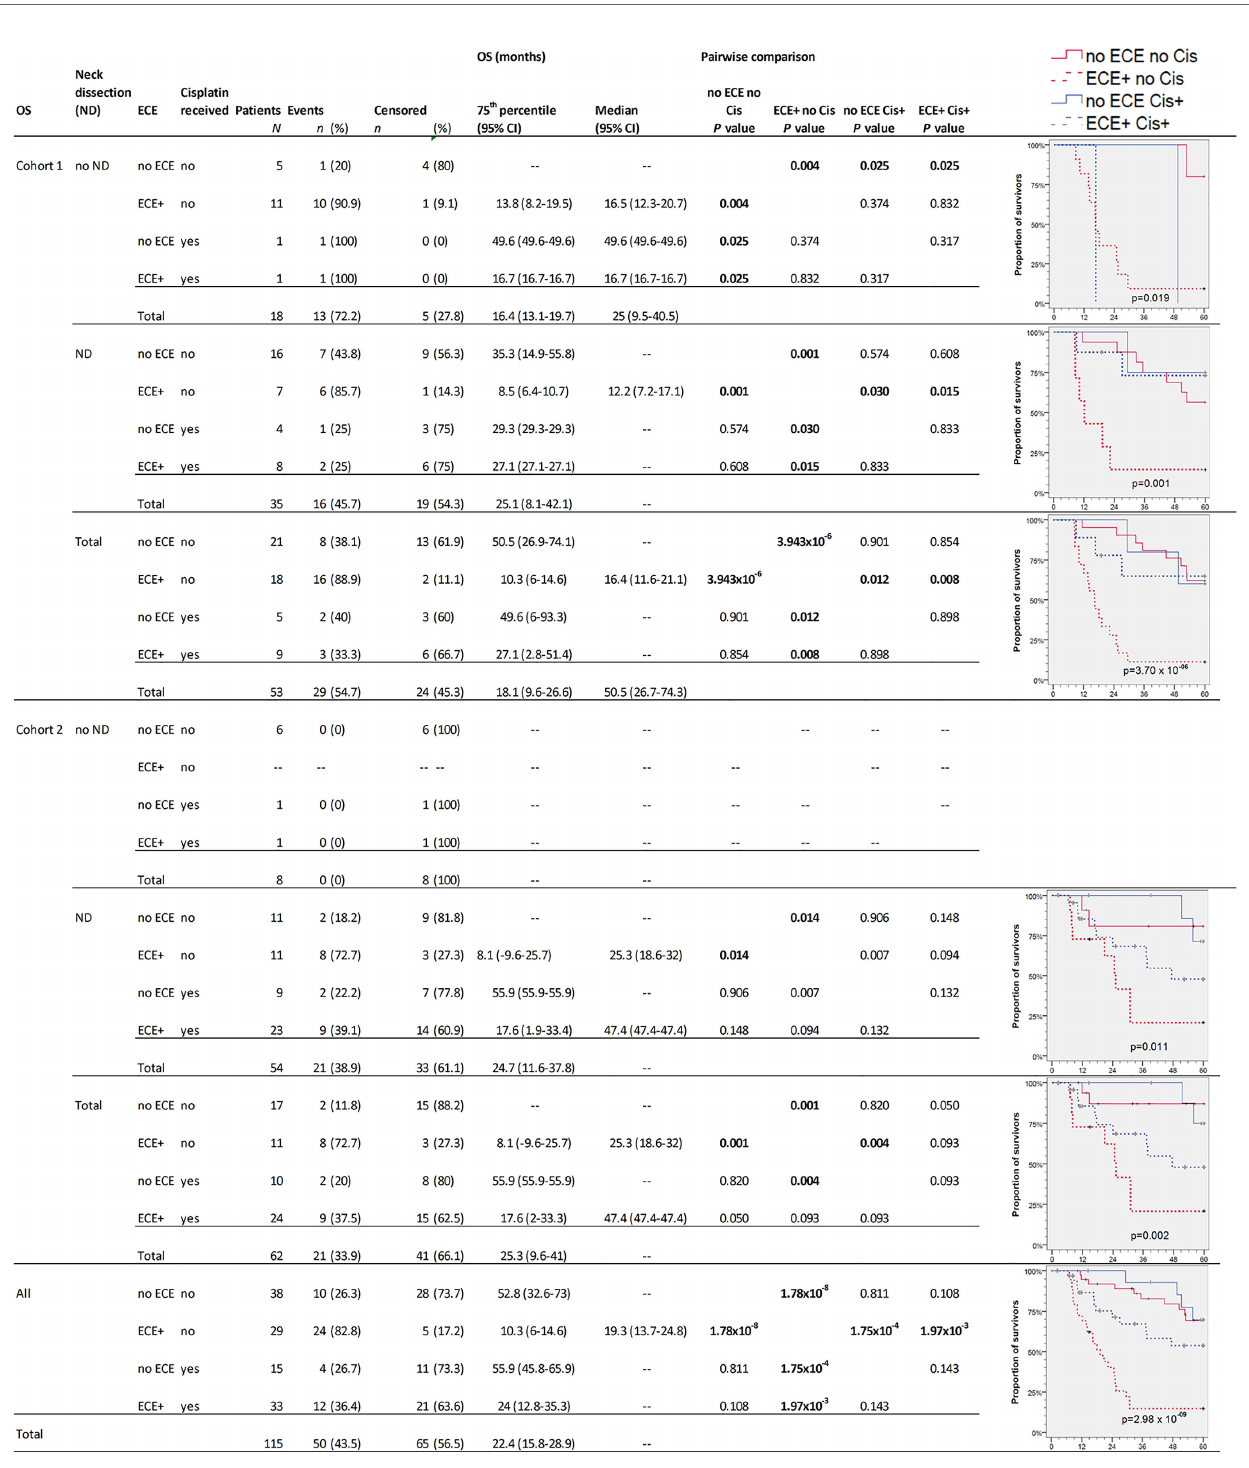
FIGURE 3 | Kaplan – Meier cumulative survival (KM) plots for overall survival (OS) of squamous cell carcinoma of unknown primary patients (NSCCUP-P) demonstrate the improved outcome achieved by standardized treatment including neck dissection (ND) and cisplatin-based radio-chemotherapy (Cis+) for NSCCUP-P with extracapsular extension of neck nodes (ECE). Besides KM plots, the numbers of patients and events are shown with 75th percentile and median along with their respective 95% con fi dence interval (95% CI) together with P -values from pairwise comparisons in various strata combining ND, ECE and Cis in cohorts 1 and 2 as well as for all